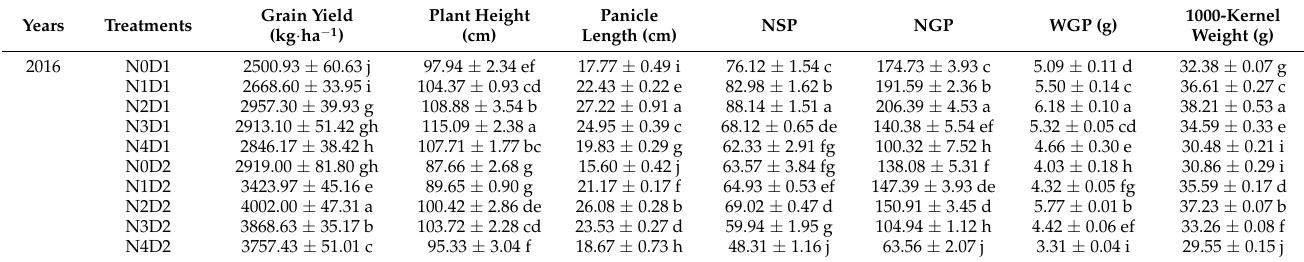
Table 3. Grain yield, plant height, panicle length, number of spikelets per panicle (NSP), number of grains per panicle (NGP), weight of grains per panicle (WGP), and 1000-kernel weight of oat in different nitrogen fertilizer and planting density treatments in two cropping seasons. Data are expressed as the mean of three replications ( n = 3). Data within a column in the same year, sharing the same letter, are not significantly different at p < 0.05; ns, not significant; * and ** significant at p < 0.05 and p < 0.01, respectively. N, D, and N × D represent nitrogen fertilizer, planting density, and the interaction between nitrogen fertilizer and planting density, respectively. N0, N1, N2, N3, and N4 represent nitrogen fertilizer rates at five levels of 0, 45, 90, 135, and 180 kg · ha − 1 , respectively. D1, D2, and D3 represent planting density at three sowing densities of 60, 180, and 300 kg · ha − 1 ,